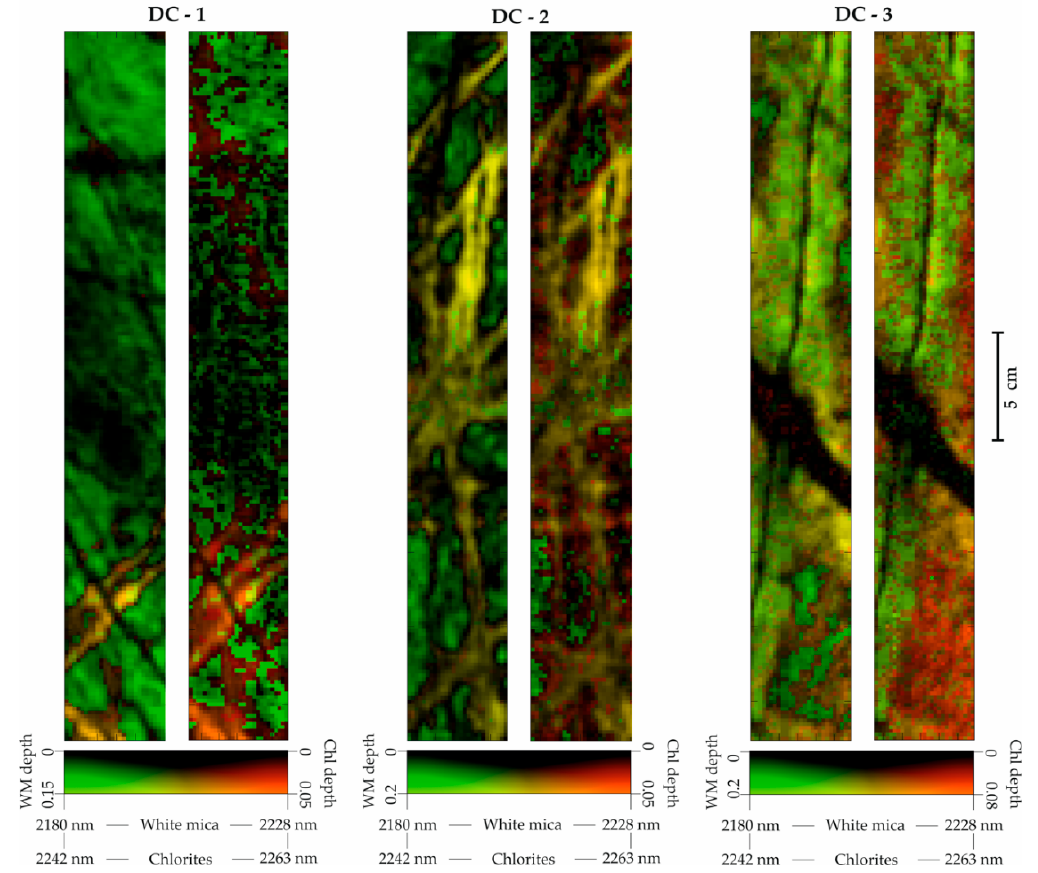
Figure A1. Minimum wavelength maps for white mica (left) and chlorites (right) for the three analyzed samples (WM = white micas, Chl = chlorites).